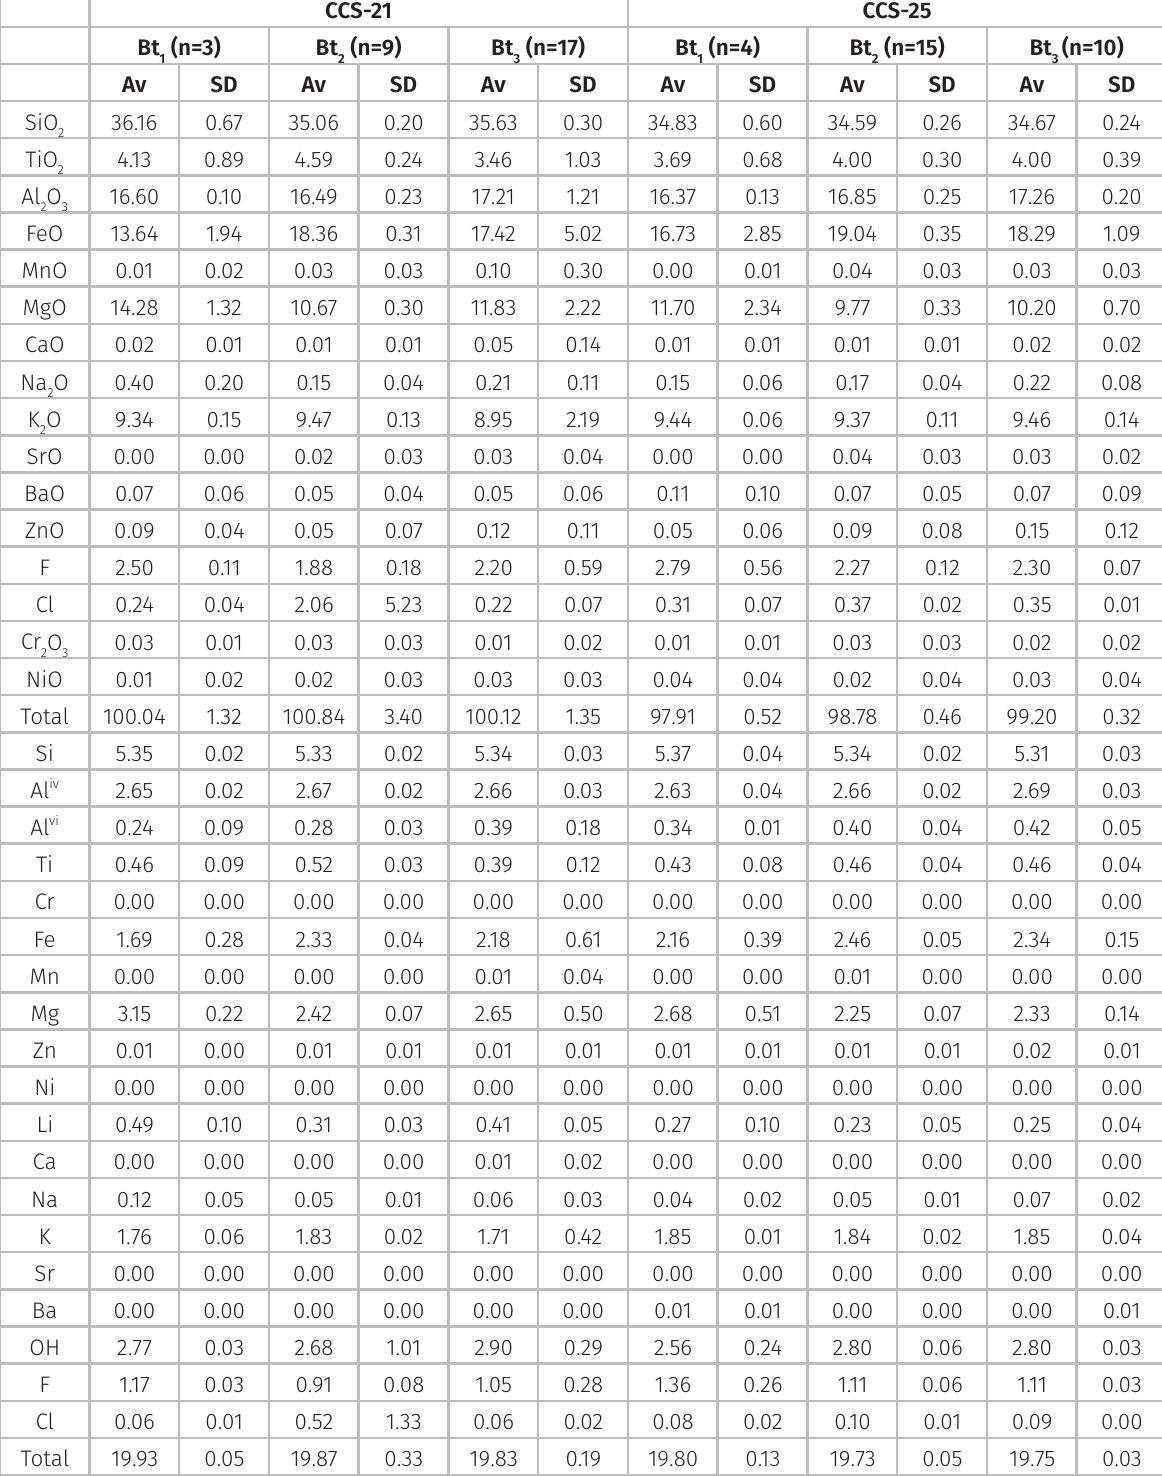
Table III. Average (Av) and standard deviation (SD) of the mineral chemistry of biotite. Calculations based on 20 oxygens, following the methodology of Tindle & Webb